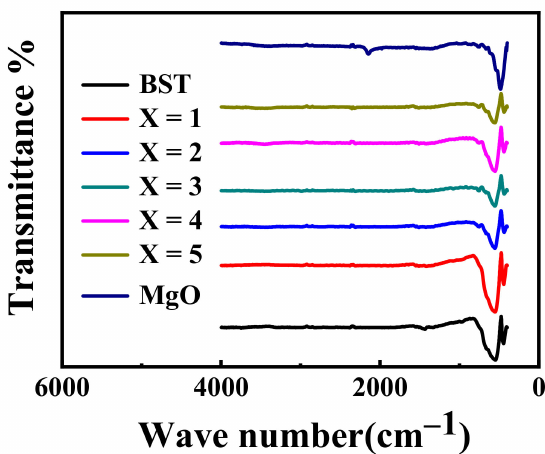
Figure 3. The infrared spectra of BST and BST- x mol% MgO ( x = 1, 2, 3, 4, 5) powders.